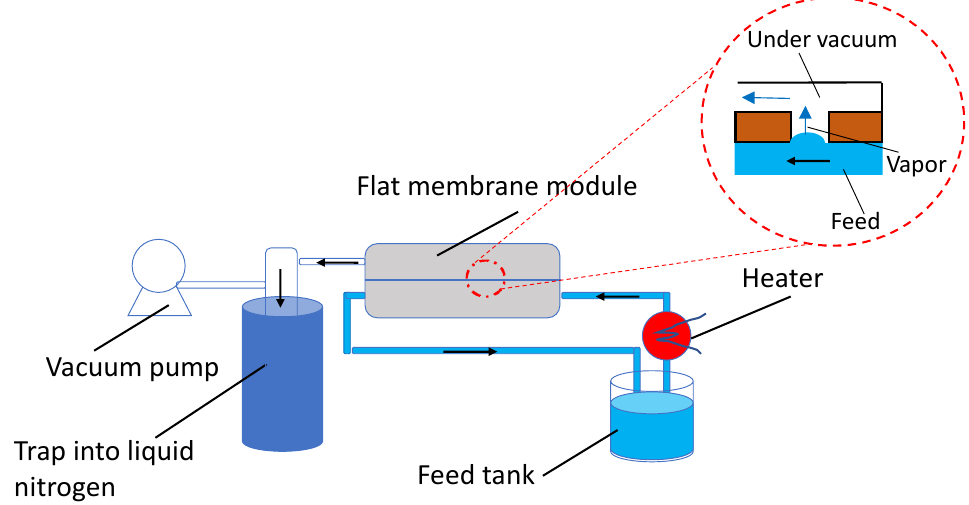
Figure 2. Scheme of the VMD lab set-up and sketch of the vapor transport through a micropore.